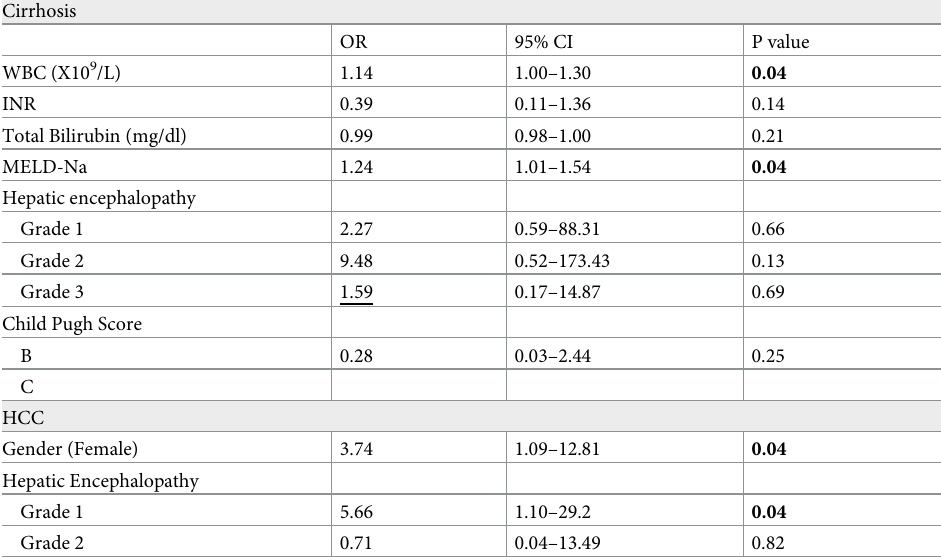
Table 5. Multivariable logistic regression analysis of predictors of in-patient mortality from liver cirrhosis and HCC.